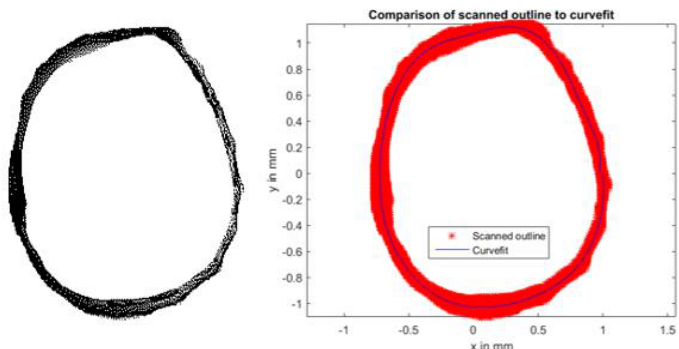
Figure 4. Manually extracted generating curve outline from cross-sectional scan of shell ( left ) and curve-fit function generated from outline ( right ).